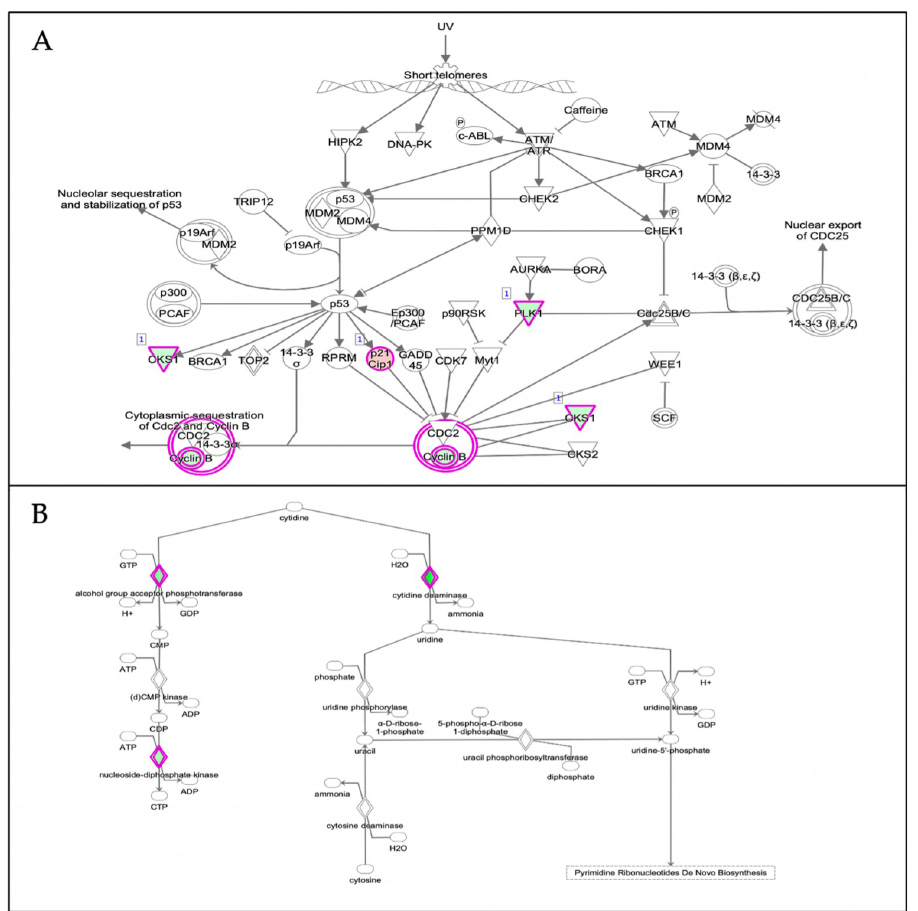
Fig 8. Depiction of the two main canonical pathway webs of a network as predicted by IPA based on the DEGs in MOL-treated hWJMSCs based on the filter criteria of p < 0.05 and z-score greater than 2 or smaller than– 2. A) Cell cycle: G2/M DNA damage checkpoint regulation (z-score = 2.000); B) Salvage pathways of pyrimidine ribonucleotides (z-score = - 2.236). Nodes represent molecules in a pathway, while the relationship between the nodes is represented by lines (edge). The reddish-purple border depicts significantly changed molecules where green colour represents downregulation and red colour means upregulation; white shapes represent molecules the pathway that was not found in our dataset. Nodes are displayed using different shapes that represent the various functional class of a gene product. For more information on the shapes and relationship type, please refer to http://qiagen.force.com/ KnowledgeBase/articles/Basic_Technical_Q_A/Legend.